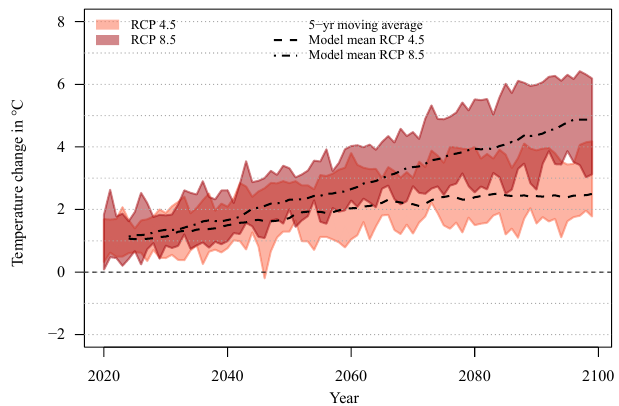
Figure 9. Anomalies of annual actual evapotranspiration (ETa) amounts relative to the reference period (1970–1999). Range of se- lected model